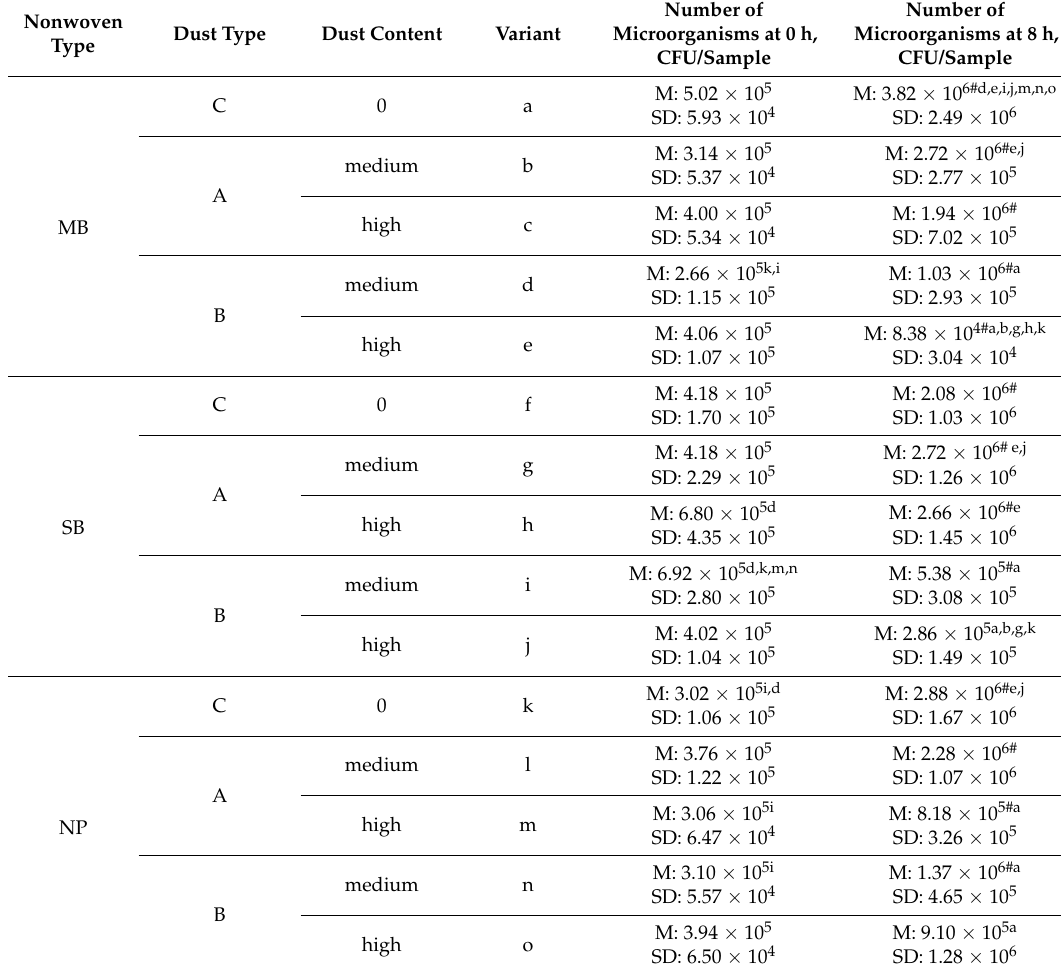
different dust content were found (Tukey test, α = 0.05).